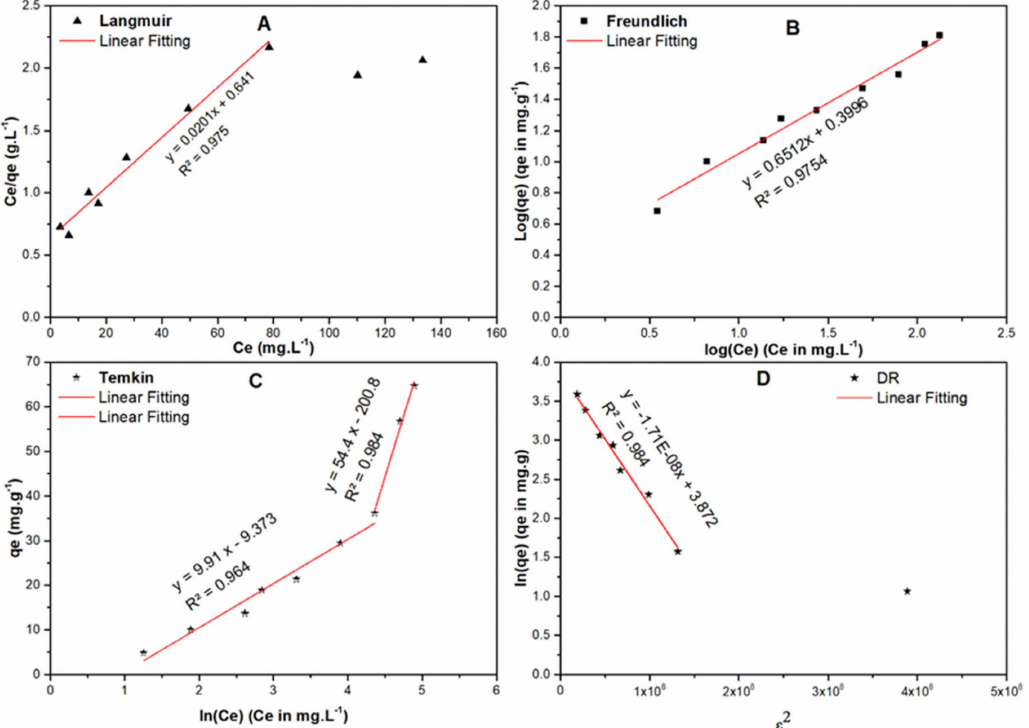
Figure 11. Adsorption isotherms of SARA onto RPNS including ( A ) Langmuir, ( B ) Freundlich, ( C ) Temkin, and ( D ) Dubinin-Radushkevich